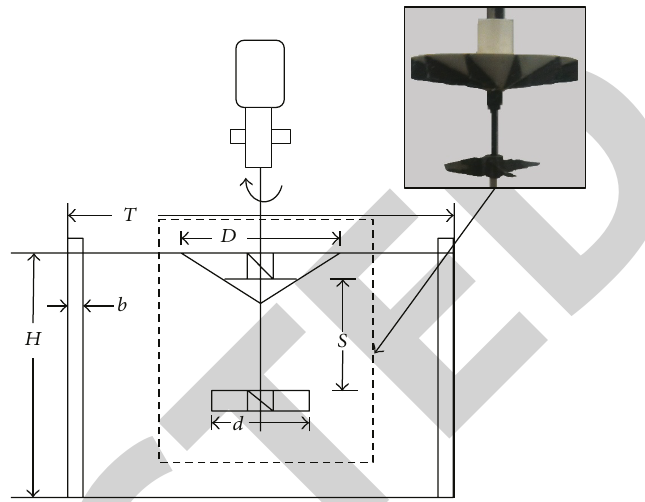
Figure 1: The schematic diagram of the experimental setup with presenting the picture of used